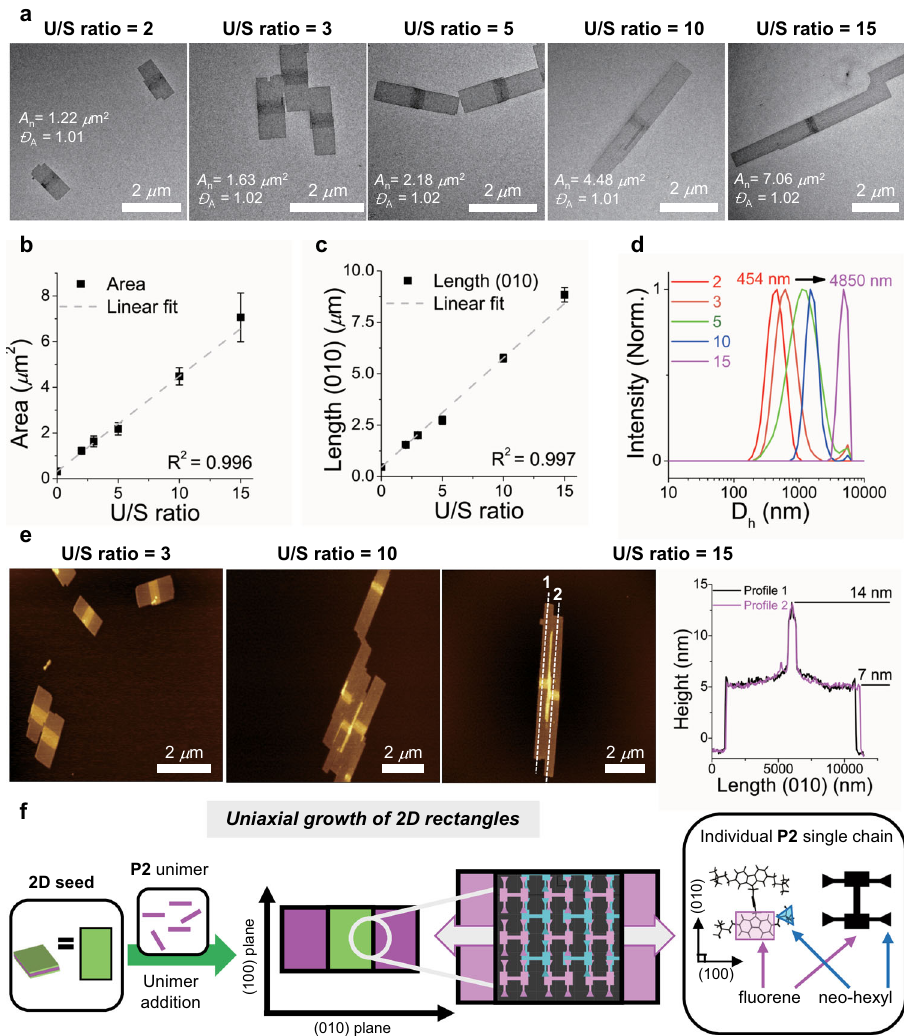
Fig. 3 Uniaxial living 2D CDSA of P2 unimer. a TEM images of length and area-controlled 2D rectangles with U/S ratios of 2, 3, 5, 10, and 15. Numbers in the images indicate the average area ( A n ) and dispersity ( Đ A ). Plots showing the linear dependence of b the area ( A n ) and c the average length ( L n ) in the (010) direction versus U/S ratios, demonstrating living 2D CDSA. Error bars indicate standard deviations ( σ ). d DLS pro fi les showing an increase in D h from U/S ratio of 2 – 15 after three weeks of aging. e AFM images of the resulting 2D rectangles prepared from U/S ratios of 3, 10, and 15. A height pro fi le of the 2D rectangles with U/S ratio of 15, demonstrating a height difference (7.8 nm of the newly formed 2D sheets versus 14.4 nm of the original 2D seeds). Much darker middle blocks in TEM images and brighter middle blocks in AFM images indicate the 2D seeds. f Schematic representation of the living 2D CDSA via uniaxial seeded growth along the (010) direction. The 2D schematic illustration of resulting 2D rectangles is based on the interdigitating slip- stack packing model of P2 homopolymer with the simpli fi ed structure in ab plane (see Supplementary Fig. 14 for detail) 42